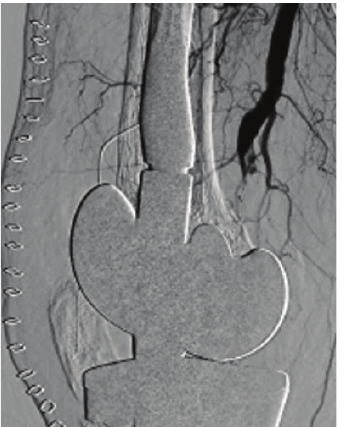
Figure 3: Arteriography of right knee showing the popliteal artery occlusion.